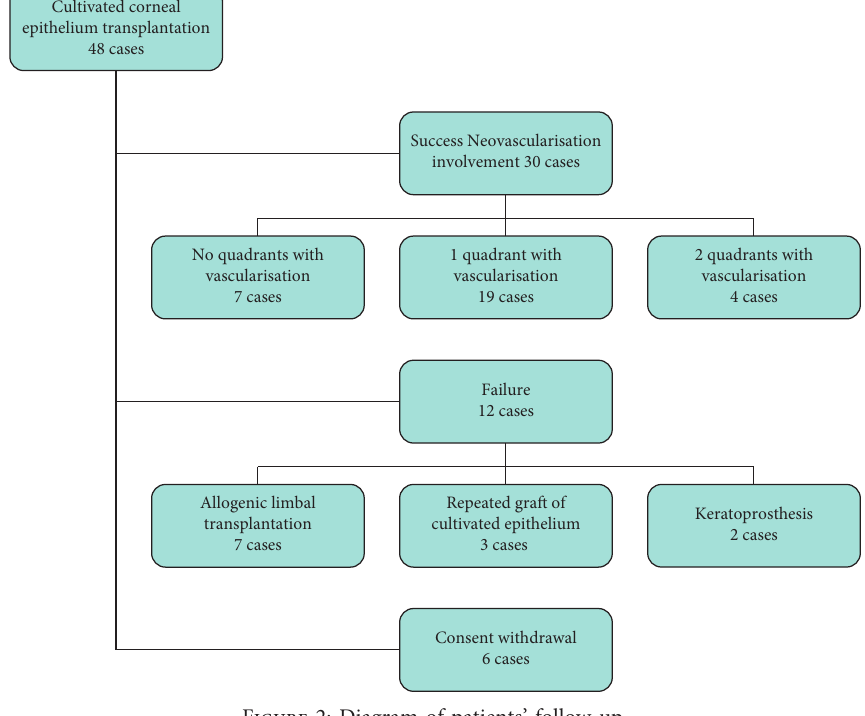
Figure 2: Diagram of patients’ follow-up.